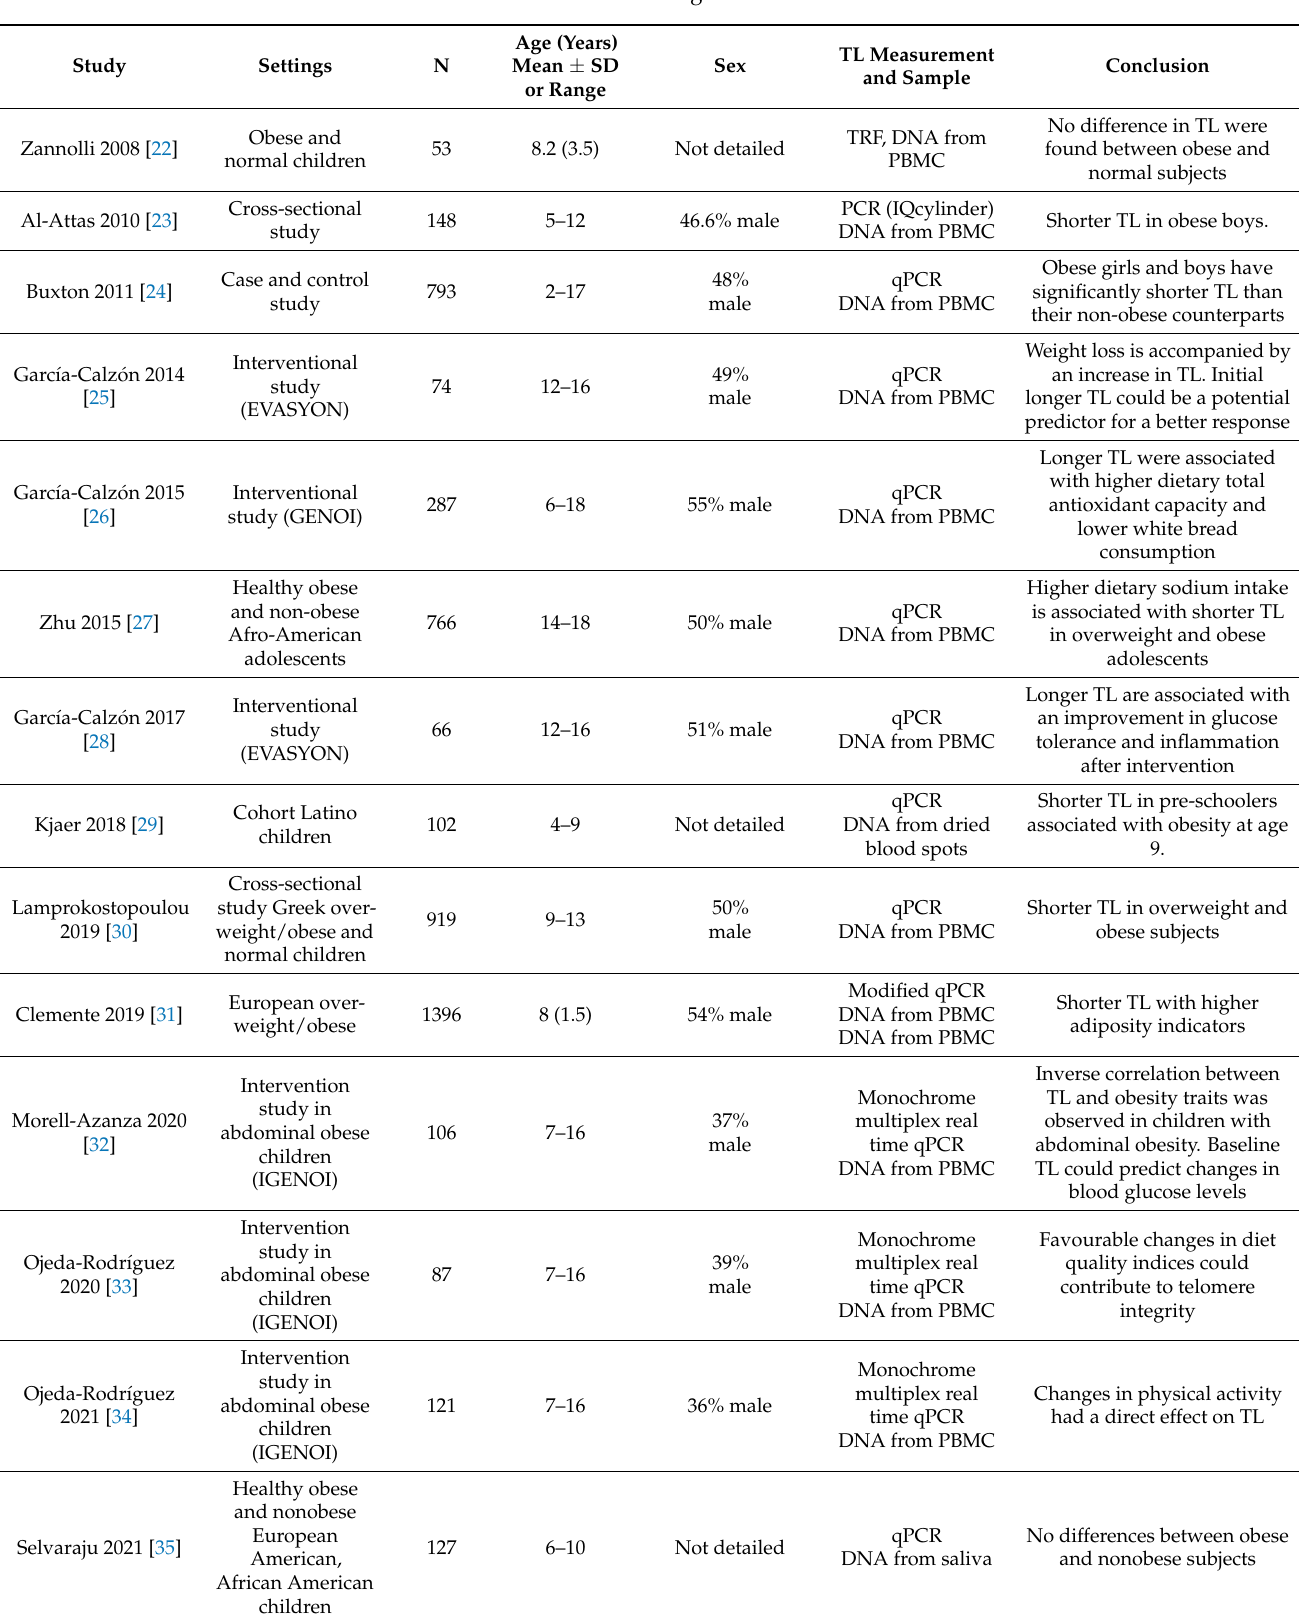
Table 1. Characteristics of the studies examining TL in obese children and